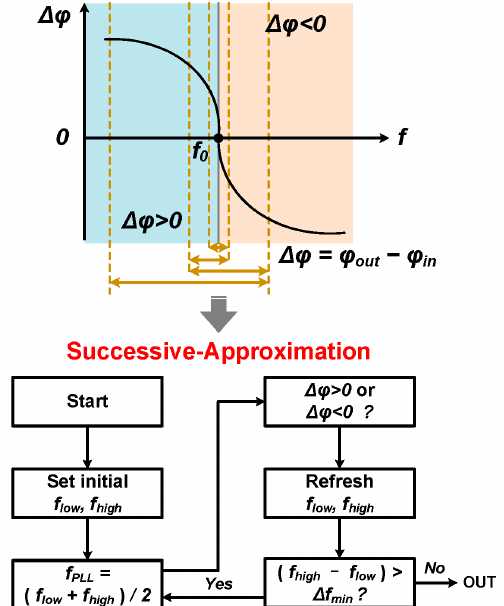
Figure 4. The basic principle of the proposed architecture (upper part: the resonance frequency f 0 corresponds to Δφ close to 0 in the phase-frequency response, the lower part: the flow chart to find the resonance frequency f 0 ).